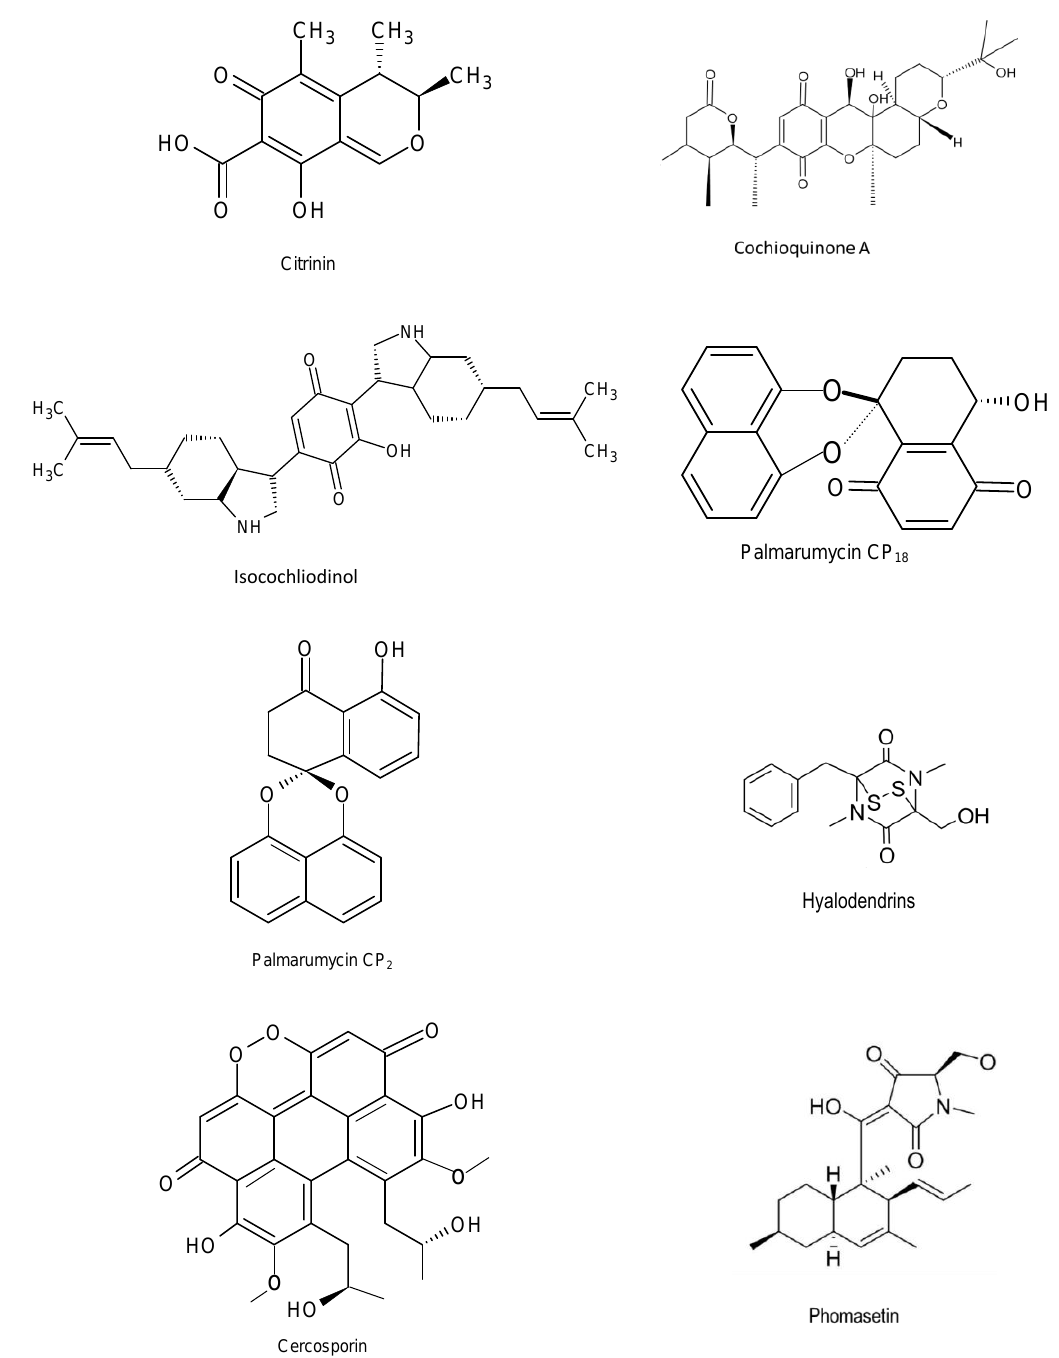
Figure 6. Chemical structures of the bioactive compounds with antiparasitic activities [20].